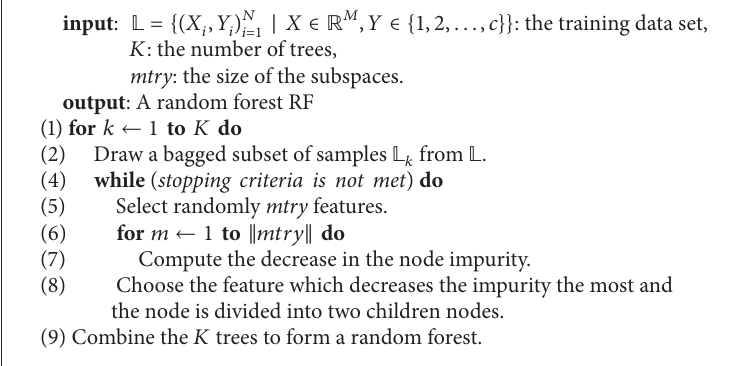
Algorithm 1: Random forest